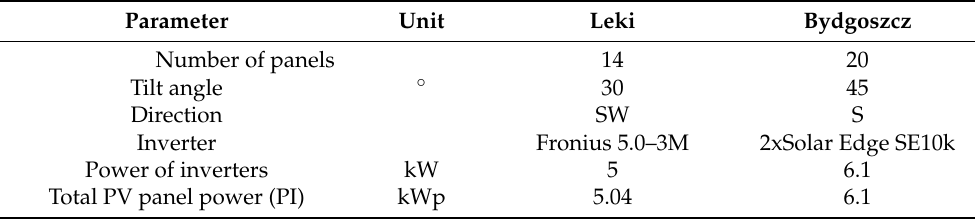
Table 2. Installation